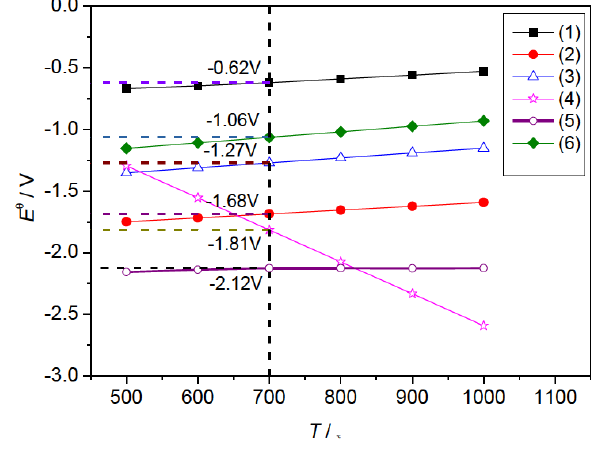
Figure 4: Relationship between the theoretical electrolysis potential E θ and T of MoO 3 at 500~1000 ∘